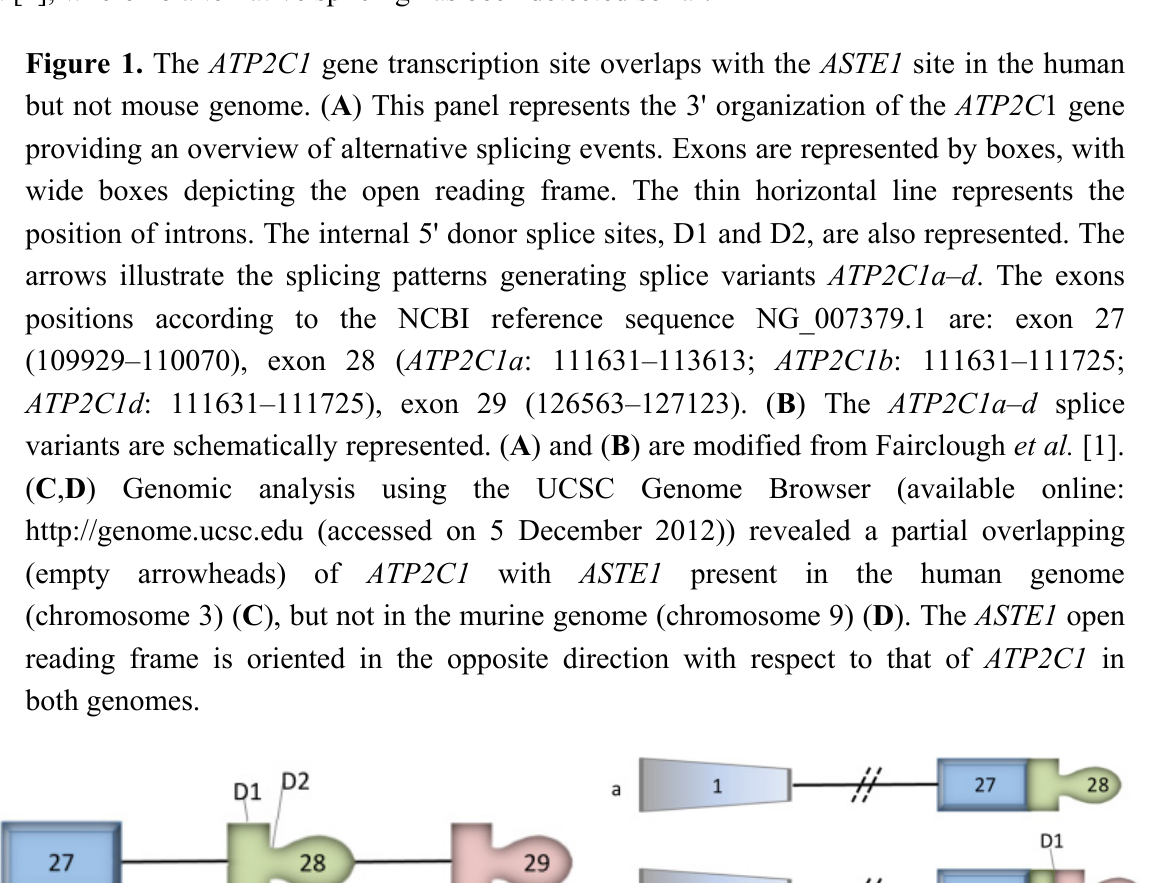
Figure 1. The ATP2C1 gene transcription site overlaps with the ASTE1 site in the human but not mouse genome. ( A ) This panel represents the 3' organization of the ATP2C 1 gene providing an overview of alternative splicing events. Exons are represented by boxes, with wide boxes depicting the open reading frame. The thin horizontal line represents the position of introns. The internal 5' donor splice sites, D1 and D2, are also represented. The arrows illustrate the splicing patterns generating splice variants ATP2C1a – d . The exons positions according to the NCBI reference sequence NG_007379.1 are: exon 27